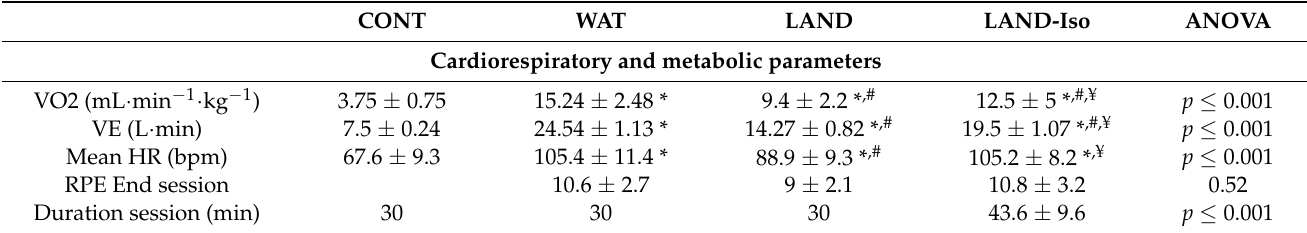
Table 2. Cardiorespiratory parameters, perceived exertion and session duration, appetite